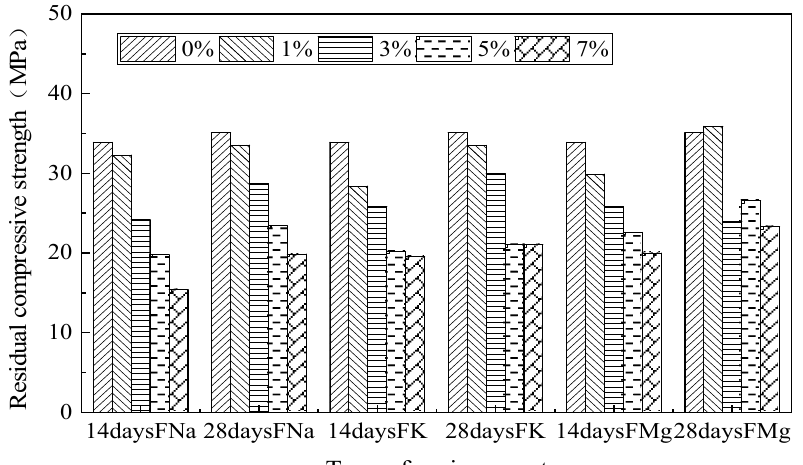
Figure 5. The secondary compressive strength of microcapsule self-healing cement specimen.